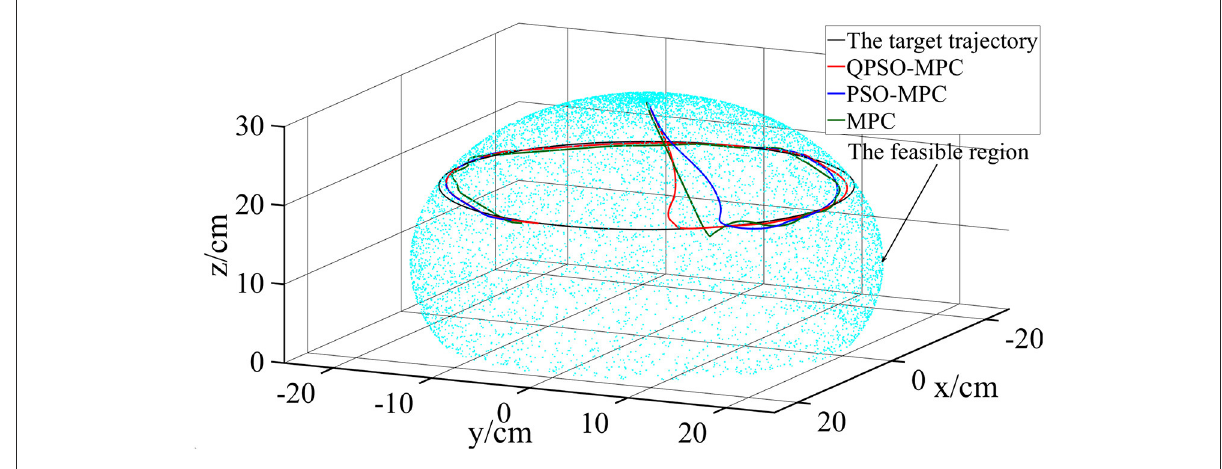
FIGURE5 Simulation results of circular trajectory